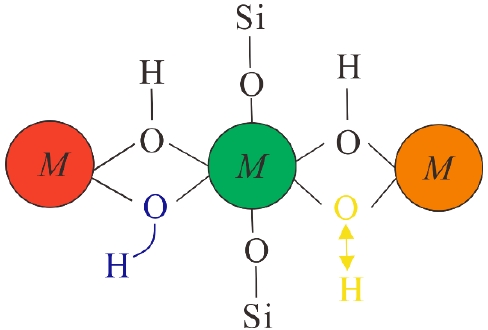
Figure 4. Schematic diagram of OH vibrations in octahedral sheet of chlorite. The OH-bending motion is shown in blue and the OH-stretching motion in yellow (modified from Bishop [20]).